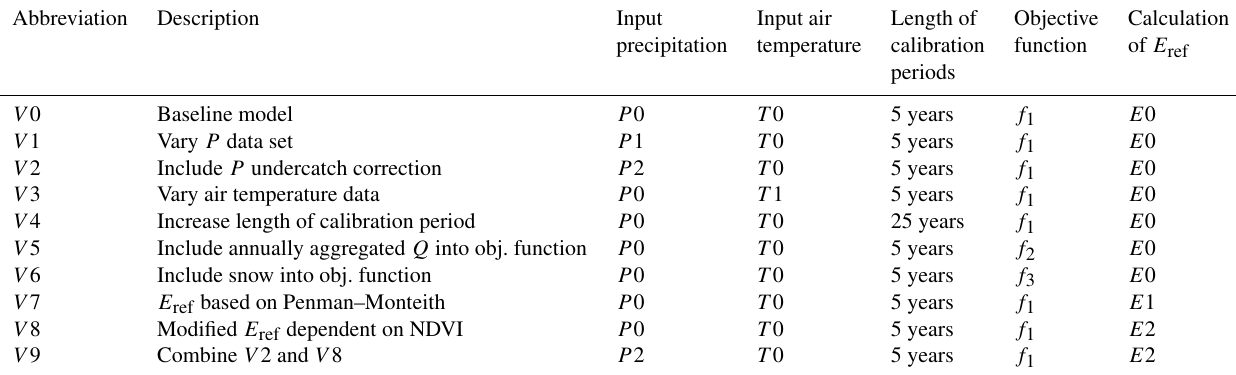
Table 3. Overview of model